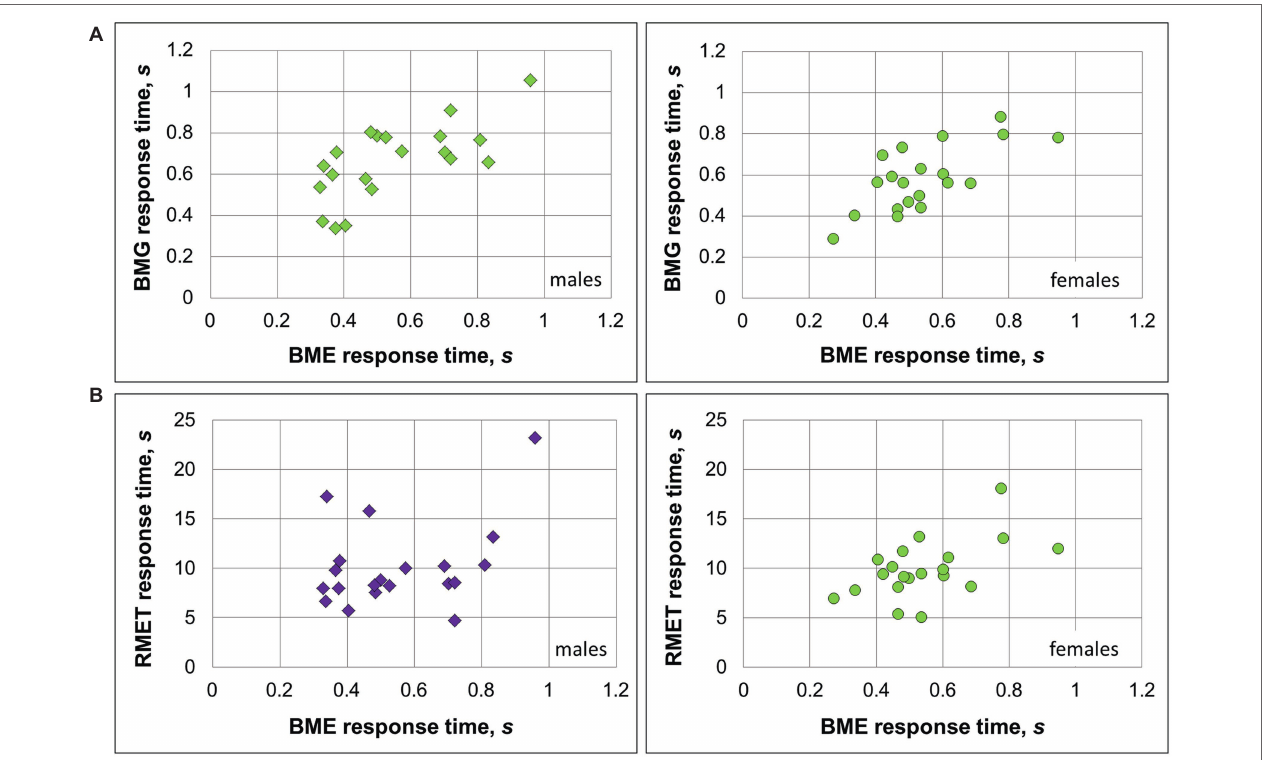
FIGURE 3 | Relationship between response time on emotion and gender recognition through biological motion, and the Reading Mind in the Eyes Test (RMET) for female and male observers. (A) Both in males (left panel, diamonds) and females (right panel, circles) BMG and BME response time were significantly linked to each other. (B) In males (left panel), response time on the BME task and RMET were not associated with each other, whereas in females (right panel) this association was significant. Significant correlations (Spearman’s ρ ; p < 0.05) are color-coded by green, non-significant correlations by